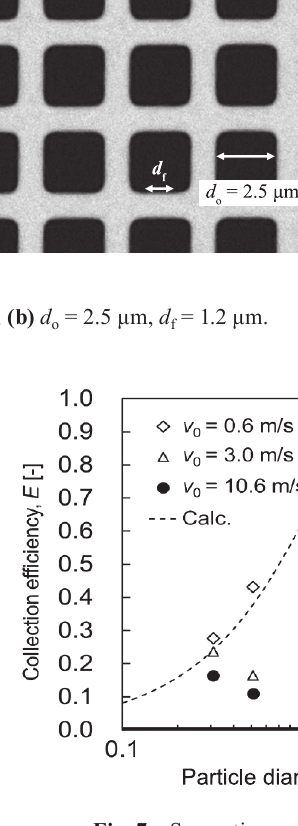
Fig. 7 Separation curve of metal